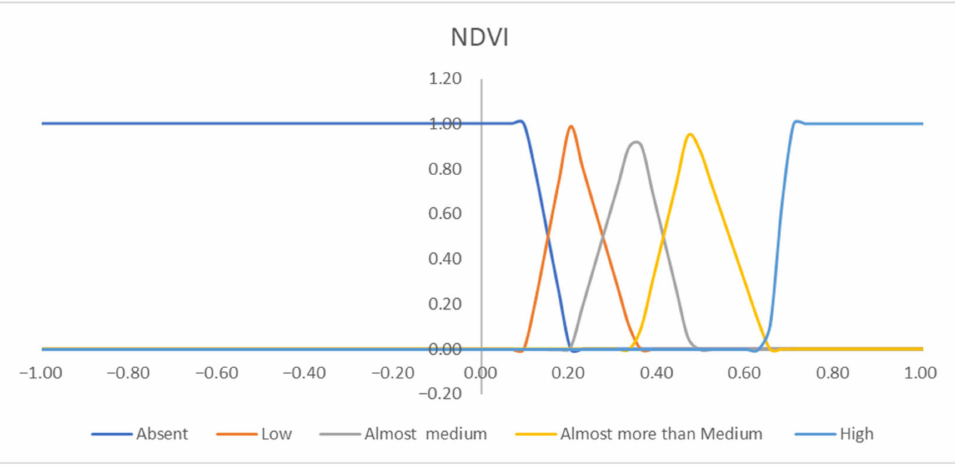
Figure 16. The third fuzzy partition of NDVI given by 6 fuzzy